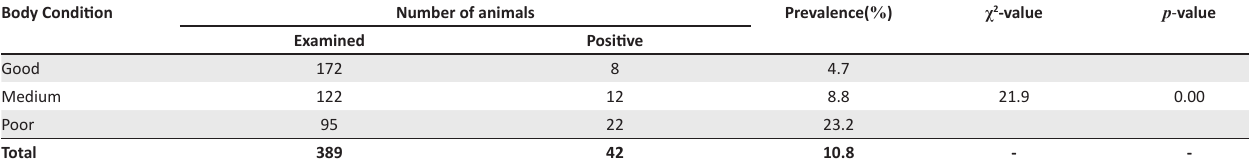
TABLE 4: Relationship between infection and body condition of